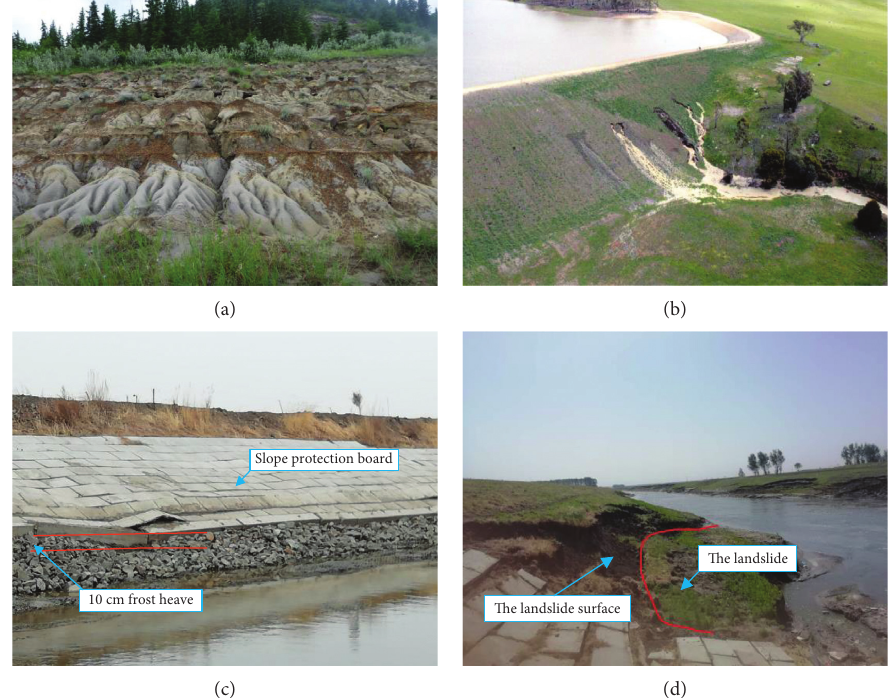
Figure 1: Main failure types of dispersive soil projects. (a) Erosion failure of dispersive soil (Canada), (b) seepage pipe failure of dispersive soil (Blackman Creek Dam), (c) frost heave failure of dispersive soil, and (d) landslide failure of dispersive